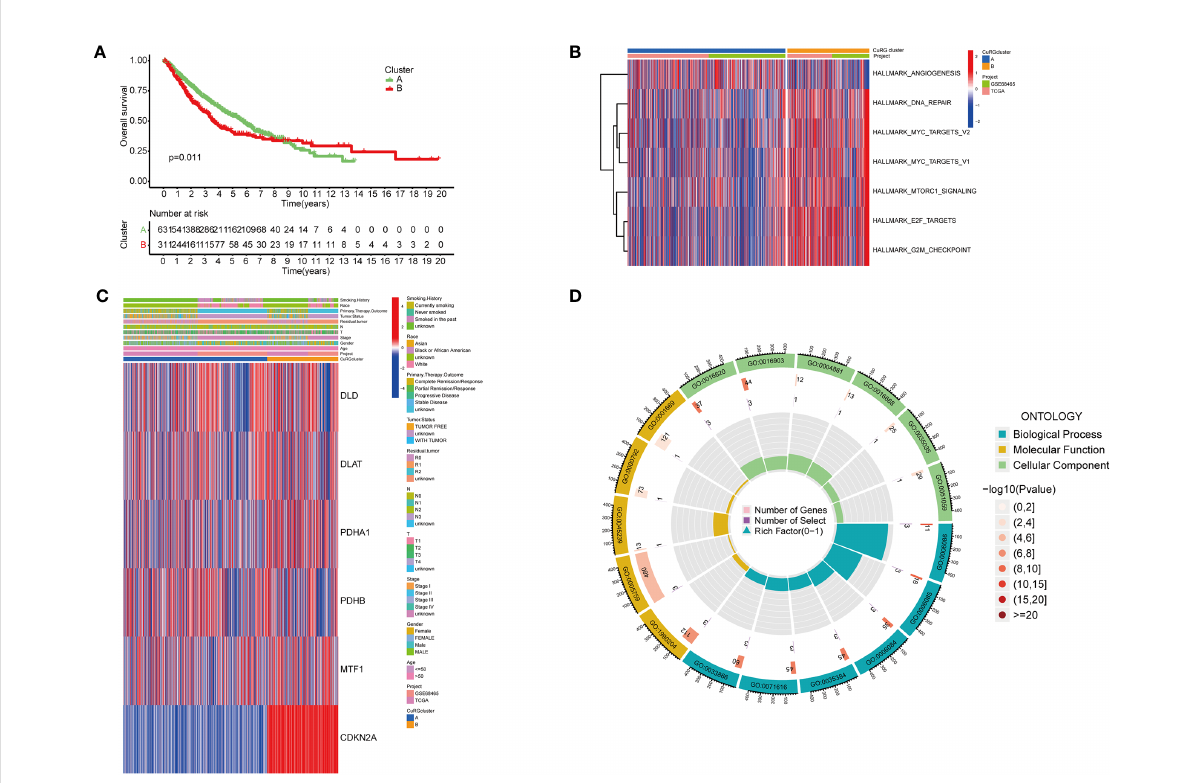
FIGURE 2 Preliminary screening of cuproptosis-related genes indicative of LUAD survival. (A) Kaplan-Meier curves for OS of two LUAD subgroups automatically clustered by transcriptomic pro fi les. (B) Enrichment analysis showing characteristics of two LUAD subgroups. Cluster B with poorer fi ve year-survival are enriched in pathways including DNA repair, MYC targets, MTORC1 signaling, E2F targets, and G2M checkpoints. (C) Expression of six cuproptosis biomarkers related to poor overall survival and their relationships with clinicopathological features. (D) GO enrichment analysis of the six-cuproptosis marker